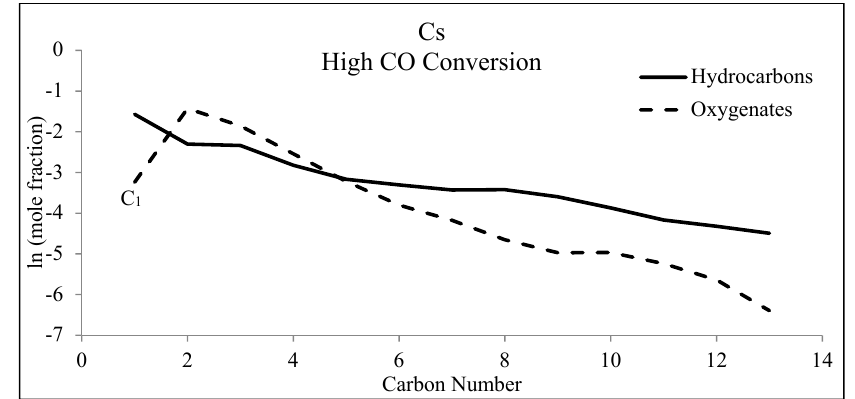
Figure 22. An ASF plot of hydrocarbons and the relative oxygenates using a cesium doped iron catalyst, ranging C 1 to C 13 (oil, water, and wax combined) for a low CO conversion sample. Reaction Conditions: 270 ◦ C, 12.1 bar, WHSV = 2, and H 2 /CO = 0.7.